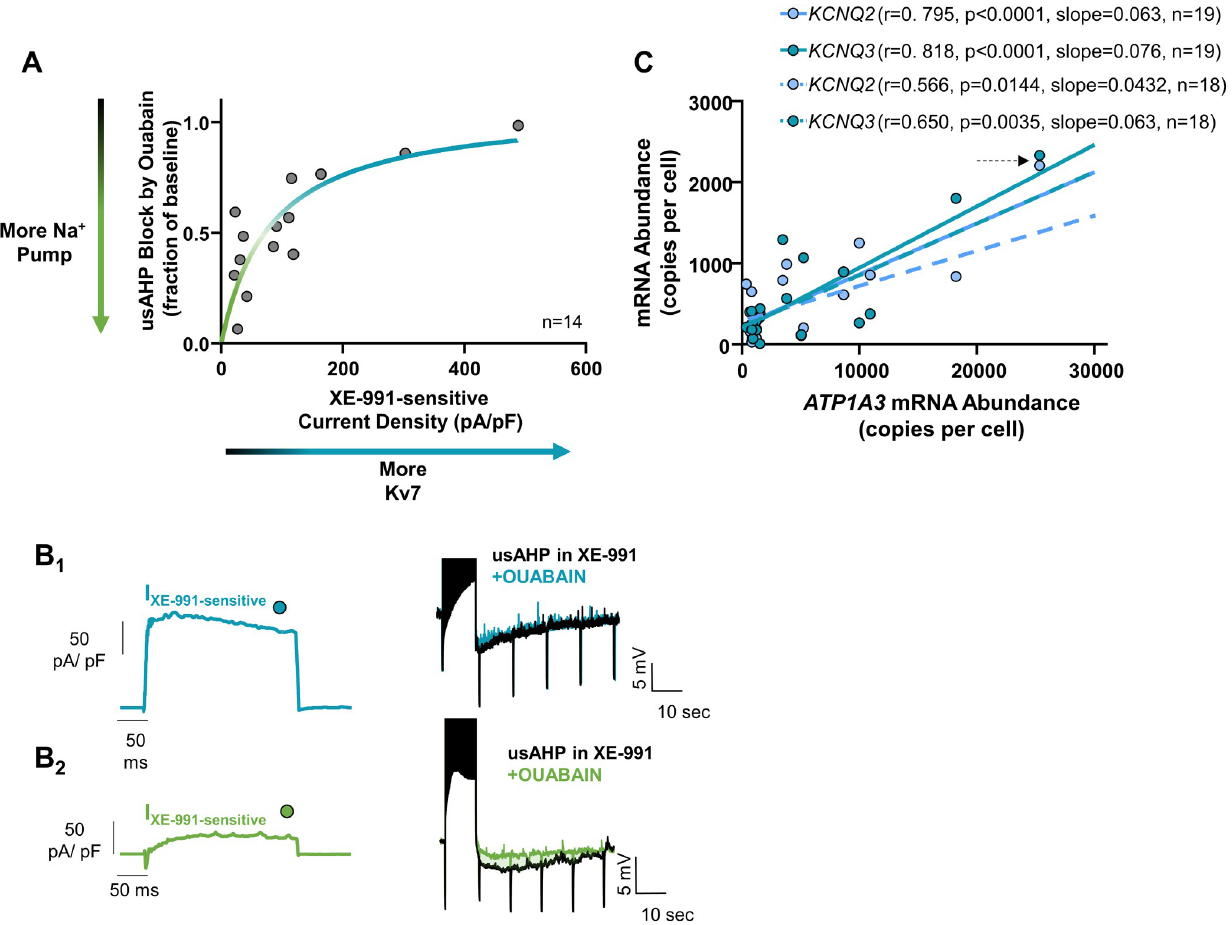
Fig 3. Co-expression of Kv7 current density and the dynamic Na + pump at functional and mRNA levels. (A) Inverse relationship between Kv7 current density and the dynamic Na + pump across neurons ( n = 14 neurons from N = 10 animals); (B 1 ) shows a neuron with a relatively large Kv7 current density (XE-991 difference current recorded at − 10 mV) and low function of the dynamic Na + pump (nearly no ouabain sensitivity of the remaining usAHP); (B 2 ) shows the opposite example, a neuron with relatively small Kv7 current density but a larger contribution of the dynamic Na + pump to the usAHP. (C) KCNQ2 and KCNQ3 (Kv7 subunits) mRNA expression from single neurons correlate with ATP1A3 , the gene that codes for the Na + affinity α subunit of the Na + pump. Each point represents the mRNA for each gene from a single neuron ( n = 19 neurons from N = 8 animals). Arrow points to values identified as outliers in the Grubbs’ test. The dotted lines indicate the regression lines for each correlation run without the outlier point, with Pearson r, p value, and slope of the relationship shown in the key. The data underlying this figure can be found in S1 Data.